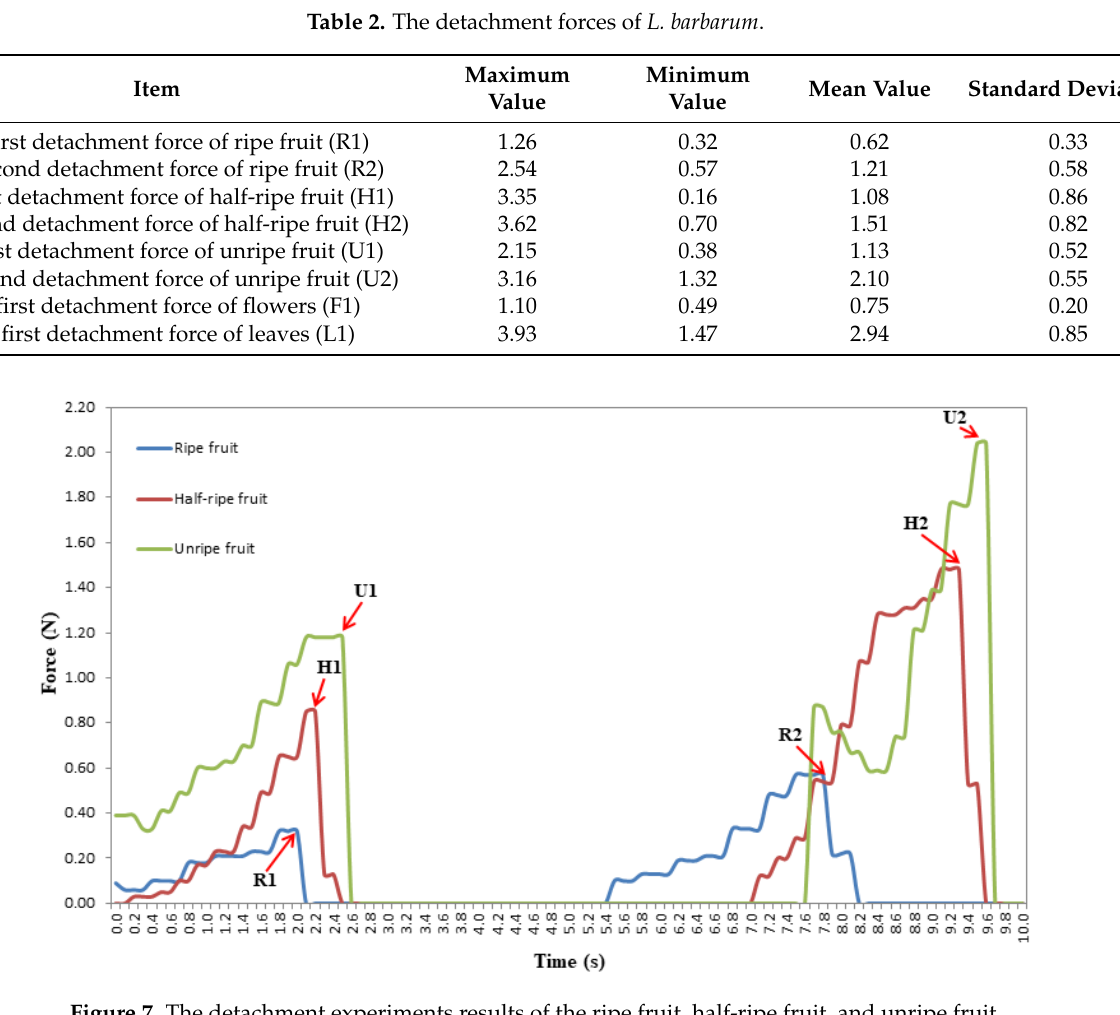
Figure 7. The detachment experiments results of the ripe fruit, half-ripe fruit, and unripe fruit.